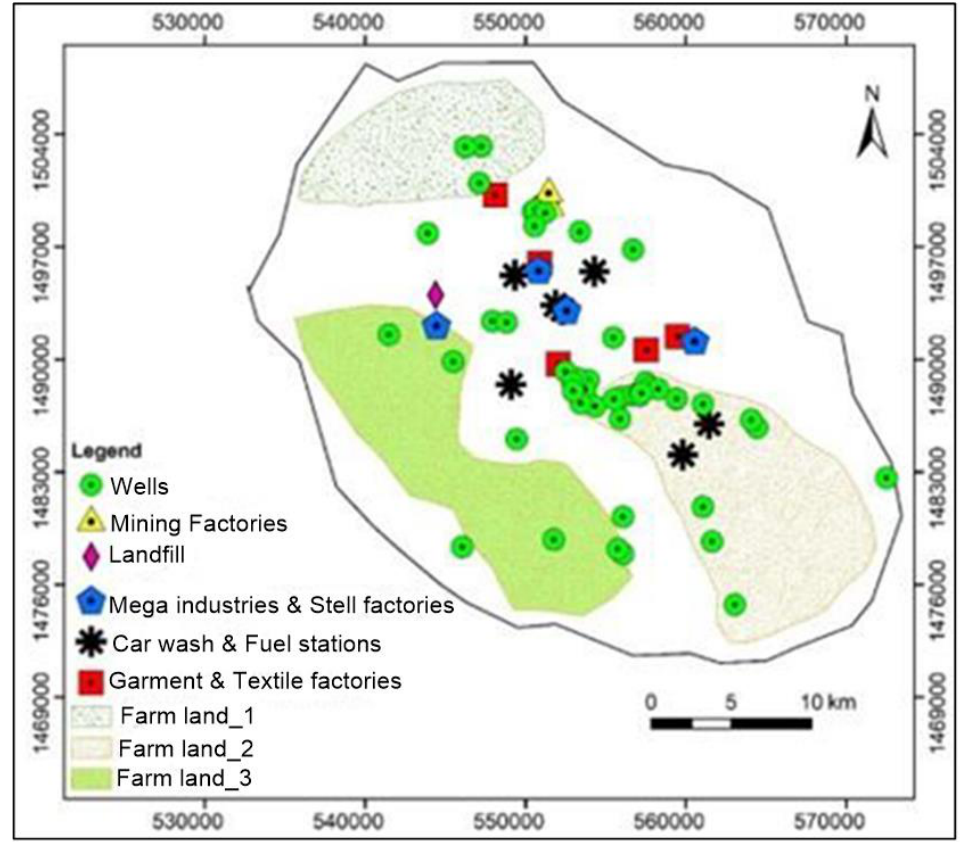
Figure 9. Water wells and potential sources of anthropogenic